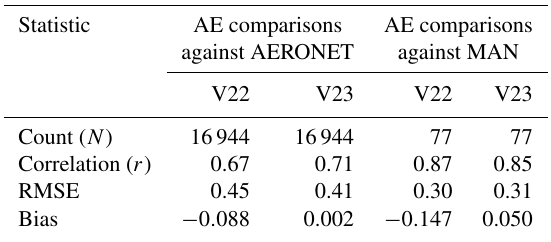
Table 1. Matched MISR–AERONET and MISR–MAN AE statis- tics for V22 and V23 (AOD > 0 .